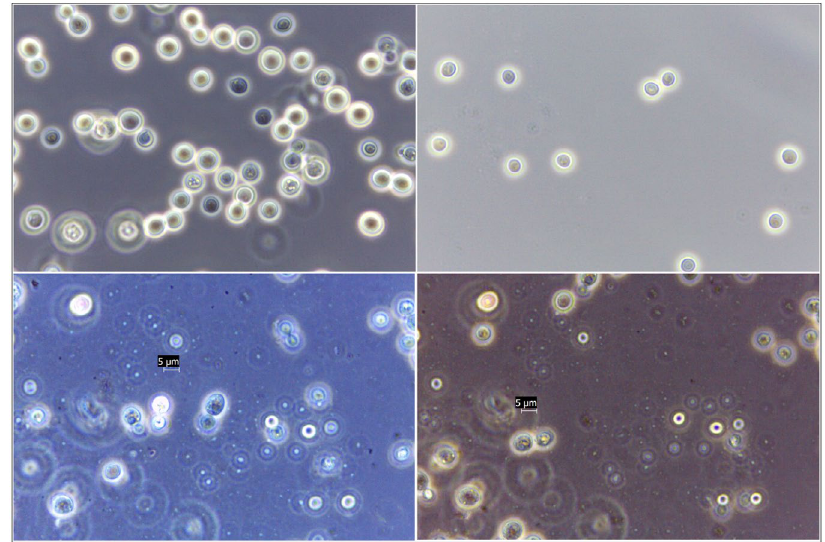
Fig. 9. Phase contrast microscopy of Papiliotrema laurentii under 100x magnification